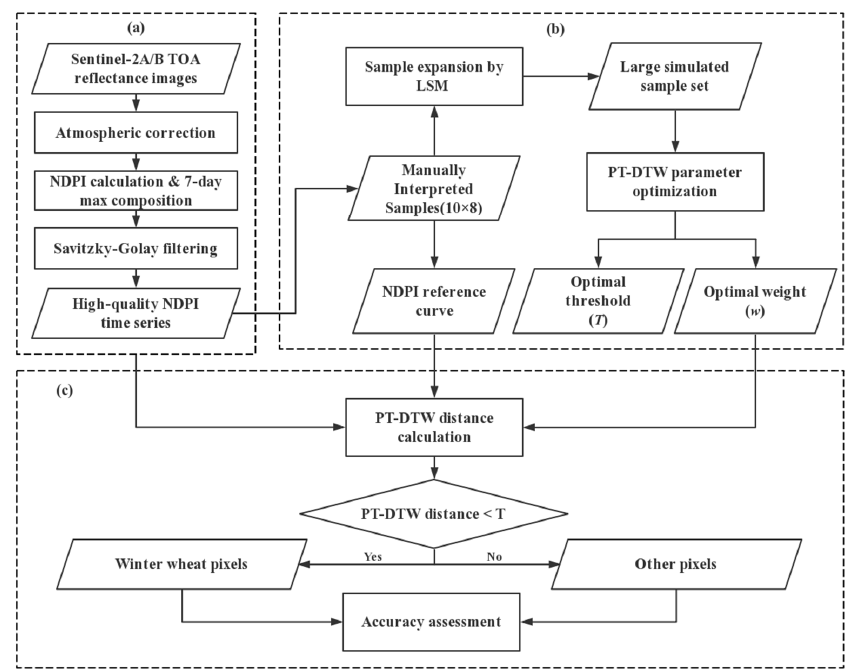
Figure 4. Workflow of the phenology-time weighted dynamic time warping (PT-DTW) method for winter wheat mapping. ( a ) Reconstructing high-quality NDPI time series. ( b ) Optimizing the